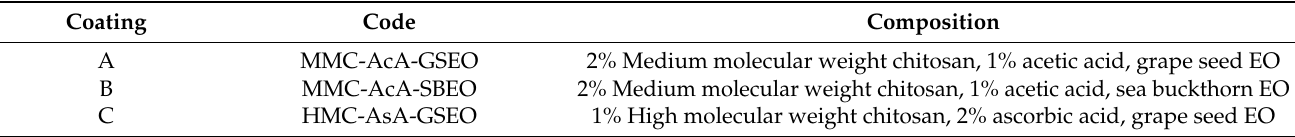
Table 1. Composition of the obtained chitosan-based edible